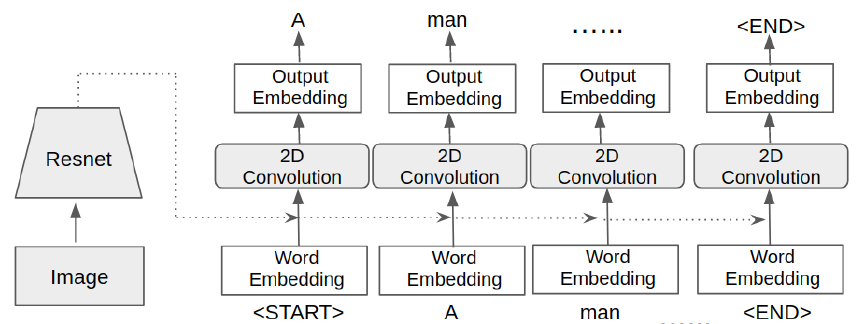
Figure 1. The architectural overview of our image captioning using the 2D-mask convolutional